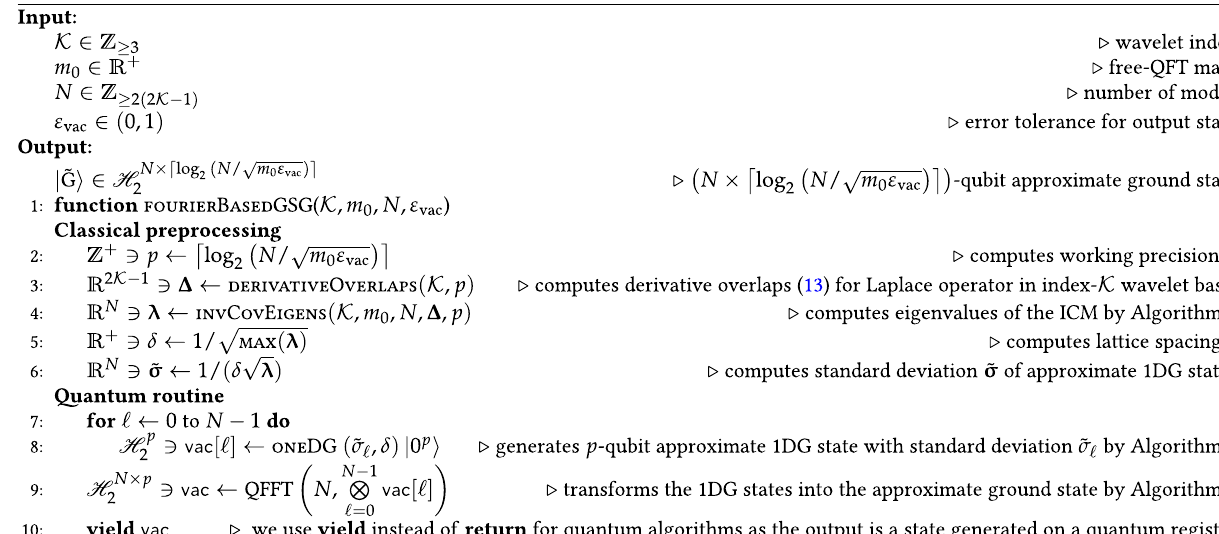
Algorithm 1. Fourier-based algorithm for ground-state